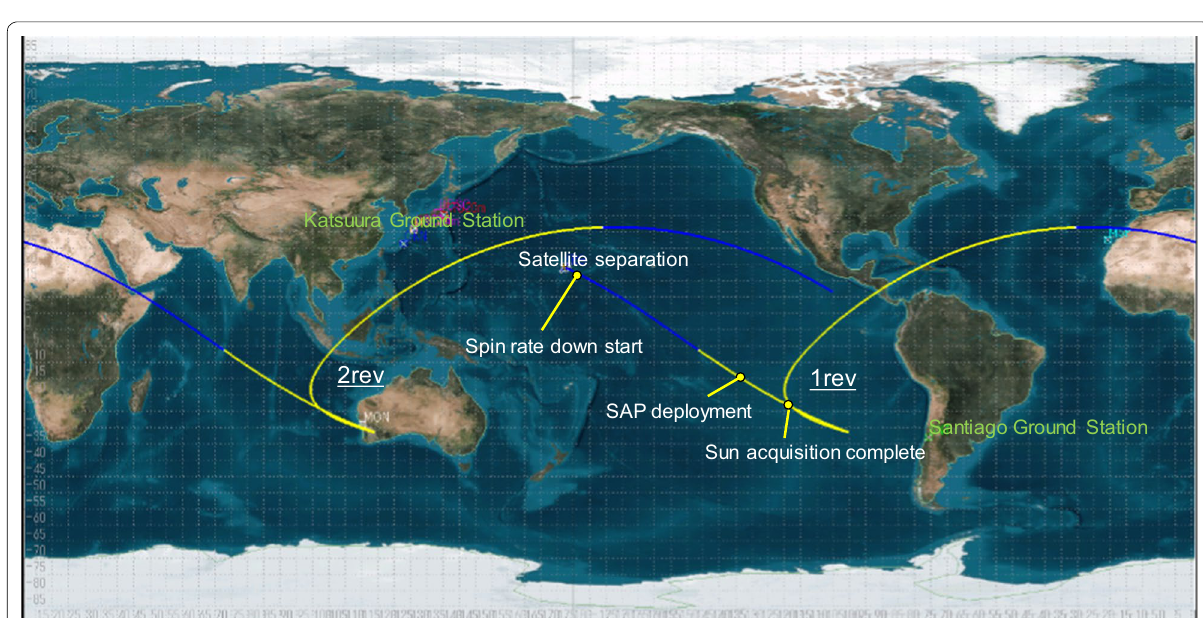
Fig. 14 Ground trace of the ERG for first two revolutions after separation from the launch vehicle. The color of the trace line is blue when the satellite is in eclipse and yellow when the satellite is in